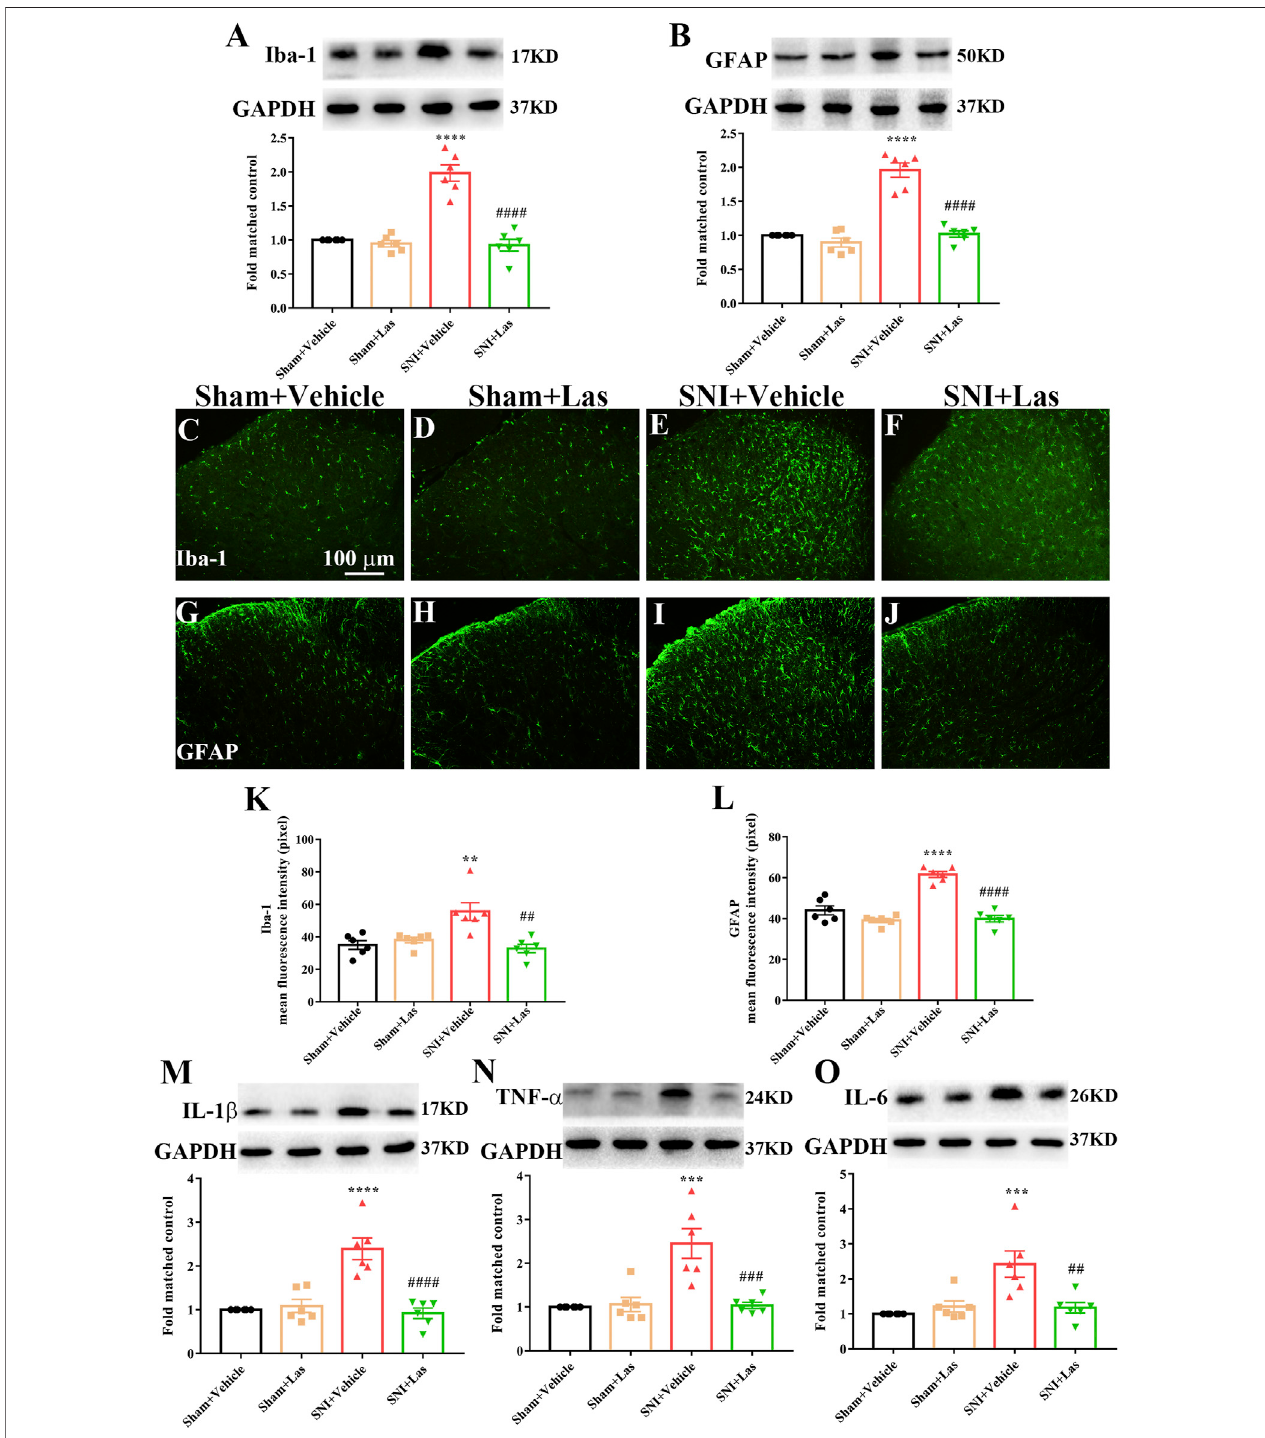
FIGURE9| Effectof5-HT 1F receptoragonistonneuroin fl ammationinthespinalcordofneuropathicpainrats. (A,B) Todeterminewhether5-HT 1F receptoragonist affectedneuroin fl ammationinSNIrats,lasmiditan(100 μ g,i.t.)wasgivenoncedailyfor fi veconsecutivedaysstartingfromday7.Twohoursafterthe fi naladministration, the L4 – 6 spinal cord was collected. The protein level of Iba1 and GFAP were signi fi cantly increased in the spinal cord of SNI rats, which were markedly suppressed by lasmiditan treatment (*** p < 0.001, **** p < 0.0001 compared with Sham + Vehicle group, ## p < 0.01, ### p < 0.001, #### p < 0.0001 compared with SNI + Vehicle group, n = 6 in each group). (C – L) The immuno fl uorescence results were consistent with the western blot (*** p < 0.001, **** p < 0.0001 compared with Sham + Vehicle group, ## p < 0.01, ### p < 0.001, #### p < 0.0001compared withSNI +Vehicle group, n=6ineach group). (M – O) Lasmiditan treatmentalso inhibited the upregulation of proin fl ammatory cytokines including IL-1 β , IL-6, and TNF- α ( Figure 10M-O , * p < 0.05, **** p < 0.0001 compared with Sham + Vehicle group, # p < 0.05, #### p < 0.0001 compared with SNI + Vehicle group, n = 6 in each group).